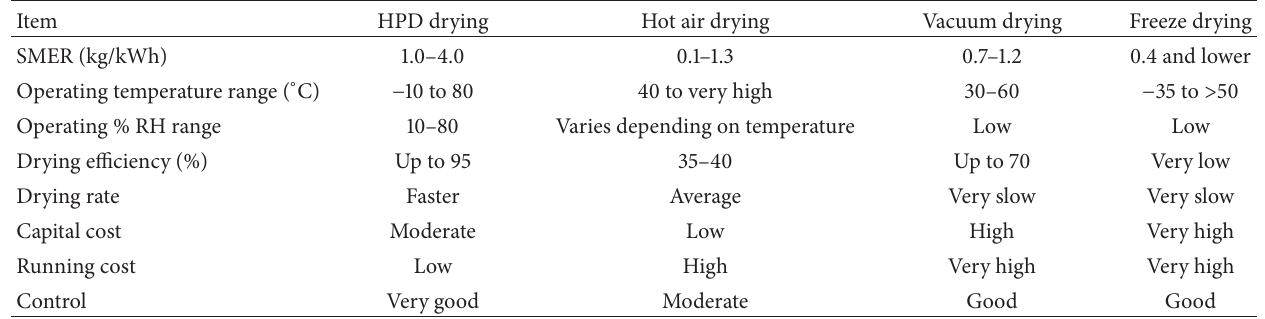
Table 1: Comparison of HPD with other commonly used dryers.